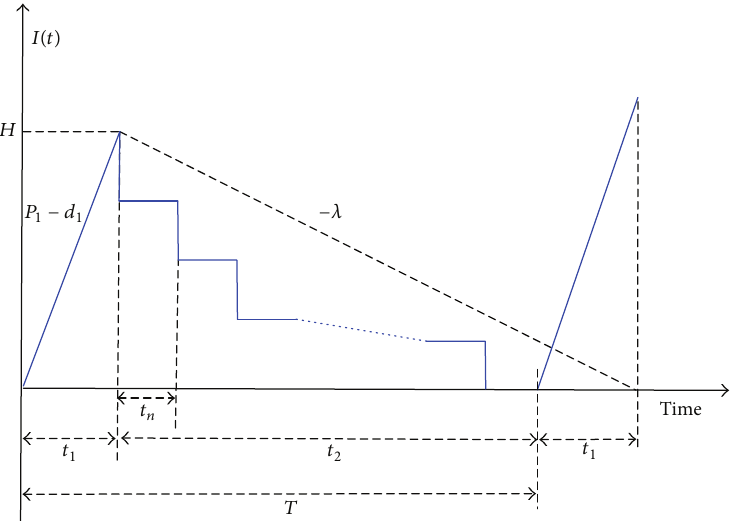
Figure 3: Inventory level of finished items in a manufacturing run time problem with no breakdown, defective rate, and discontinuous delivery